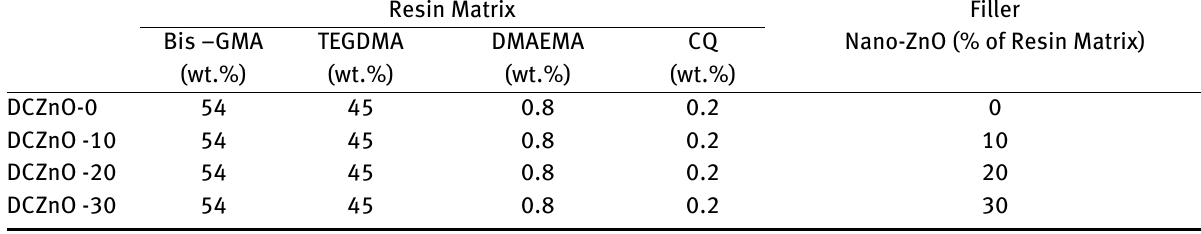
Table 2: Designation and composition of composites